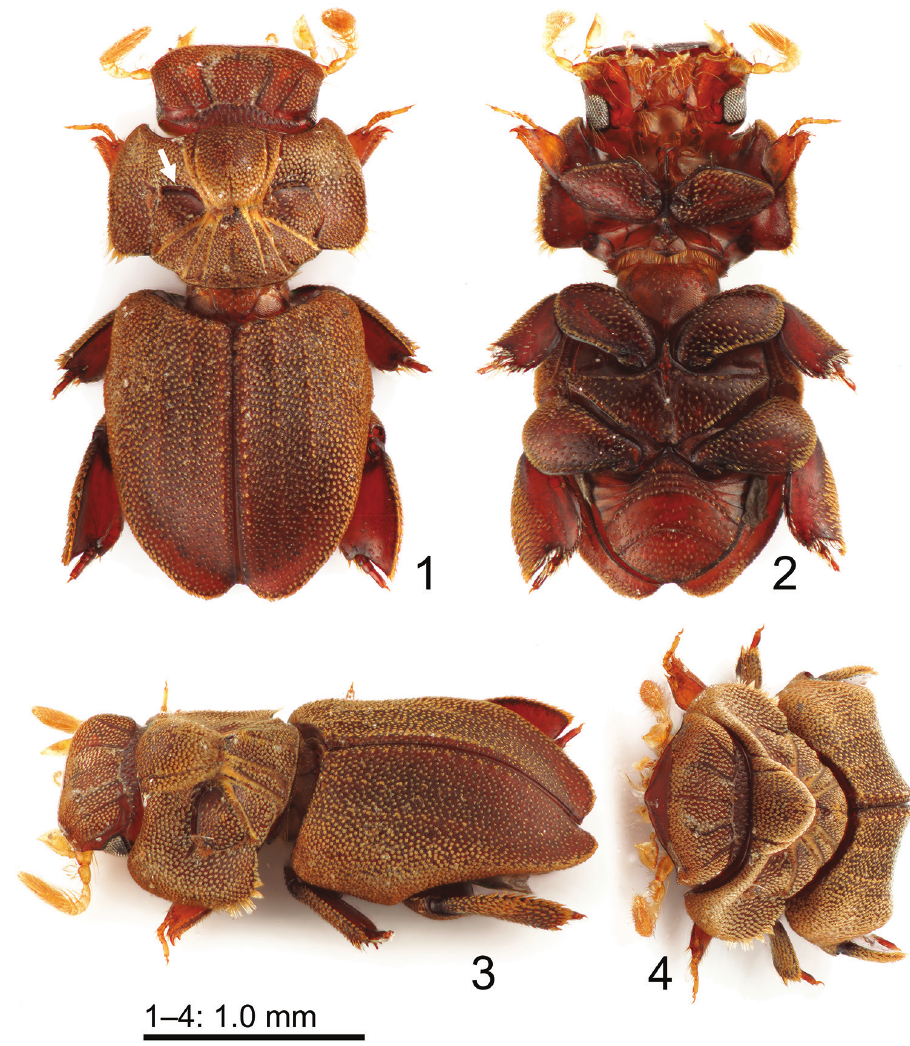
Figures 1–4. Habitus of Cheleion watanabei sp. n. ( ♀ holotype) 1 dorsal view (anterior ridge of pronotal depression arrowed) 2 ventral view 3 dorsolateral view 4 anterodorsal